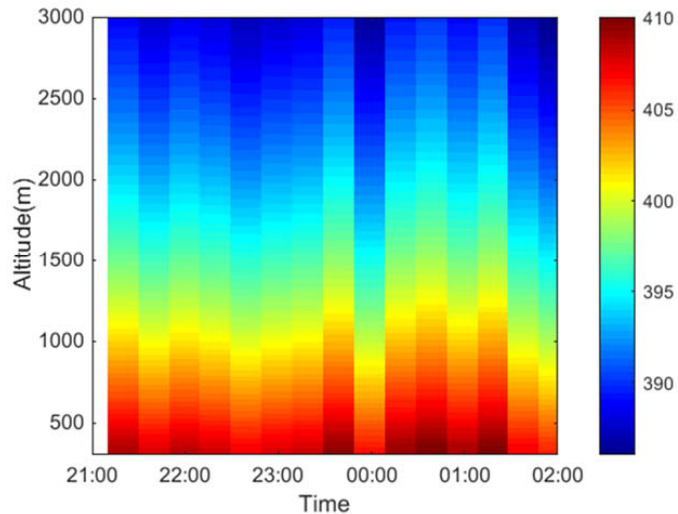
Figure 20. Pseudo ‐ color map of CO 2 vertical concentration detected using our CO 2 ‐ DIAL system. Figure 20. Pseudo-color map of CO 2 vertical concentration detected using our CO 2 -DIAL